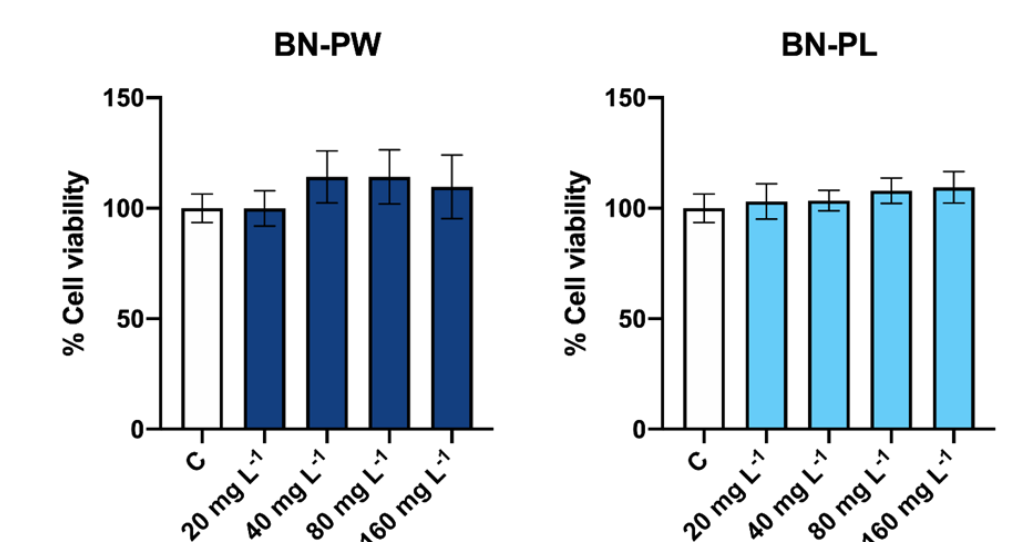
Figure 6. Human lung carcinoma (A549) cells viability after exposure to different concentrations of BN-PW and BN-PL. “C” corresponds to non-exposed cells. Two independent experiments, employing three technical replicates per exposure condition tested, were performed. One-way ANOVA followed by the Dunnett post hoc test was done to compare every mean with that of the control, and considered significant at p ≤ 0.05.